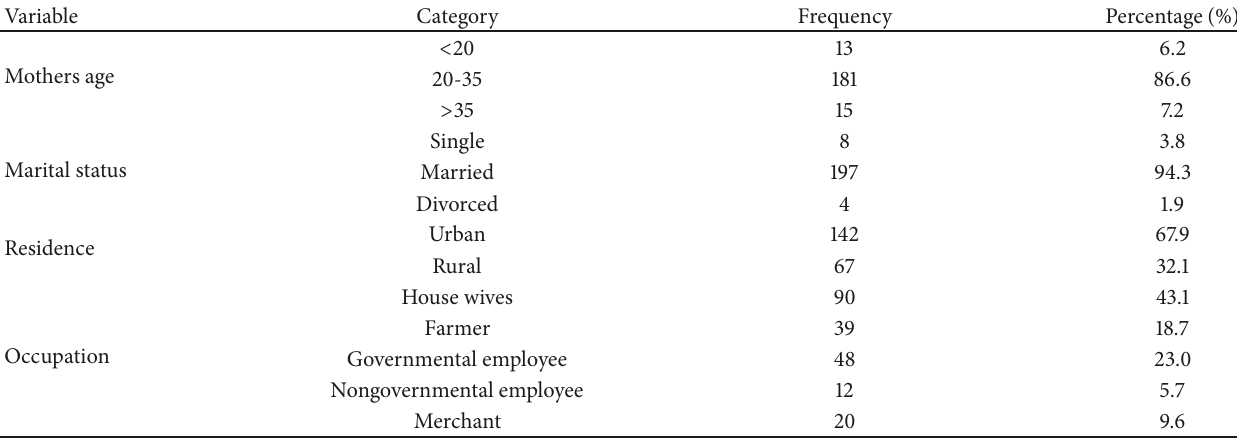
Table 1: Maternal Sociodemographic distribution of mothers at neonatal intensive care unit of Mekelle city public hospitals, Northern Ethiopia, 2016.